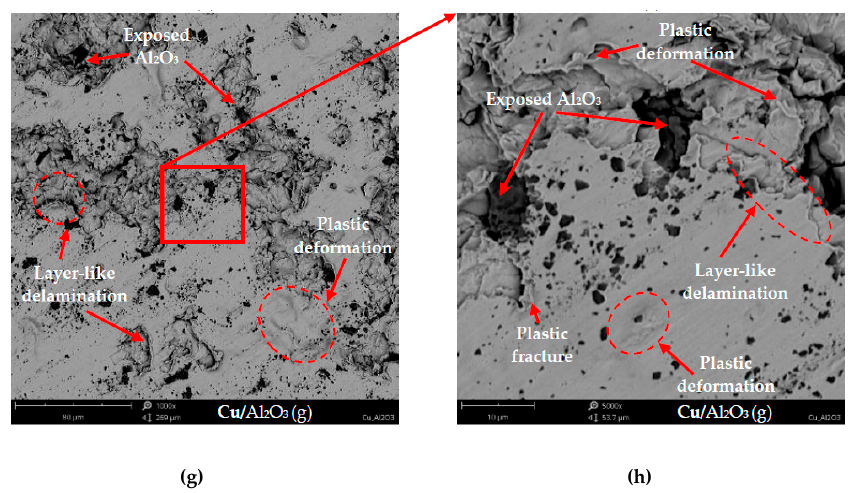
Figure 8. Cavitation-eroded composite surfaces: As-sprayed (as) and finished by grinding (g) (Figure 2 shows the preliminary surface morphologies): ( a – d ) Al / Al 2 O 3 ; ( e – h ) Cu / Al 2 O 3 coatings,